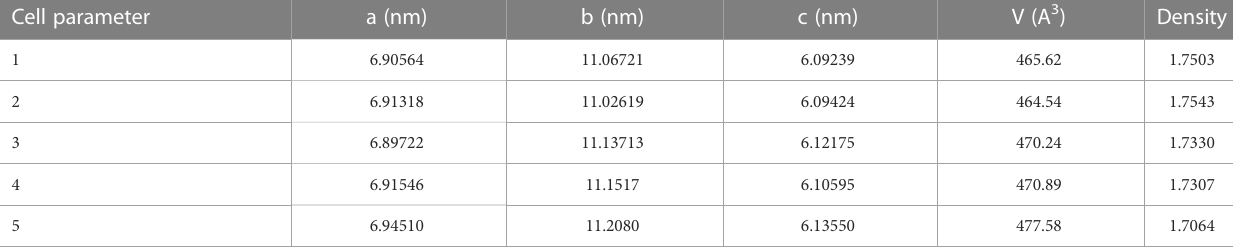
TABLE 1 The cell parameter of mineral crystals analyzed by Jade